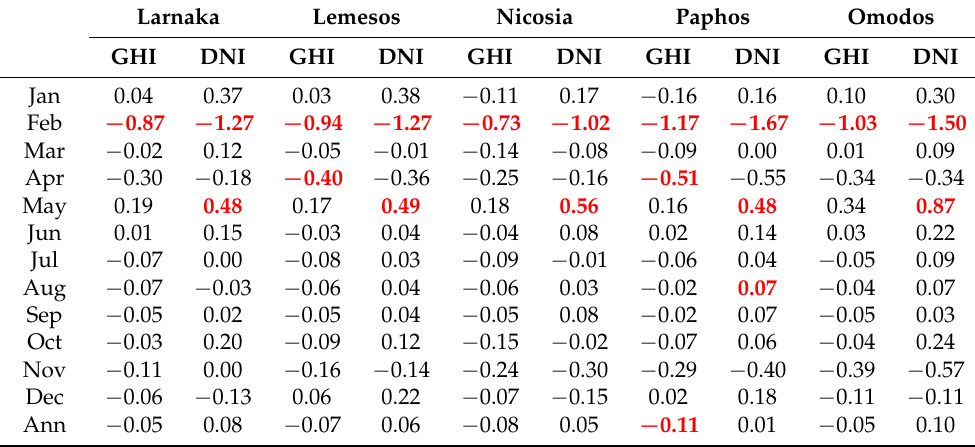
Table A1. Trends in the attenuation (%) of the monthly and annual GHI and DNI by